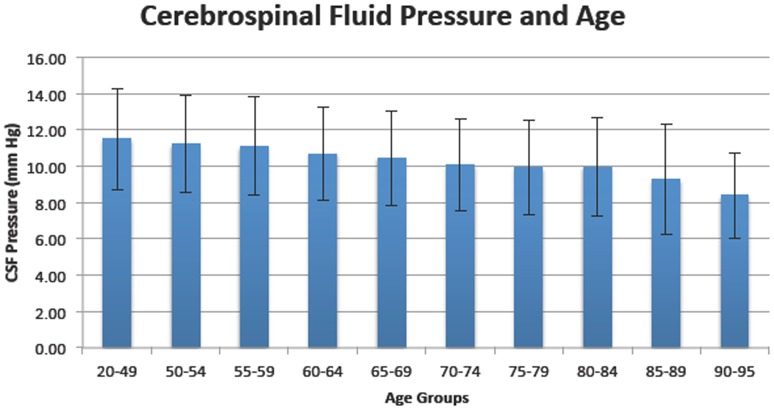
Mean CSFP within specific age groups.Bars represent one standard deviation.